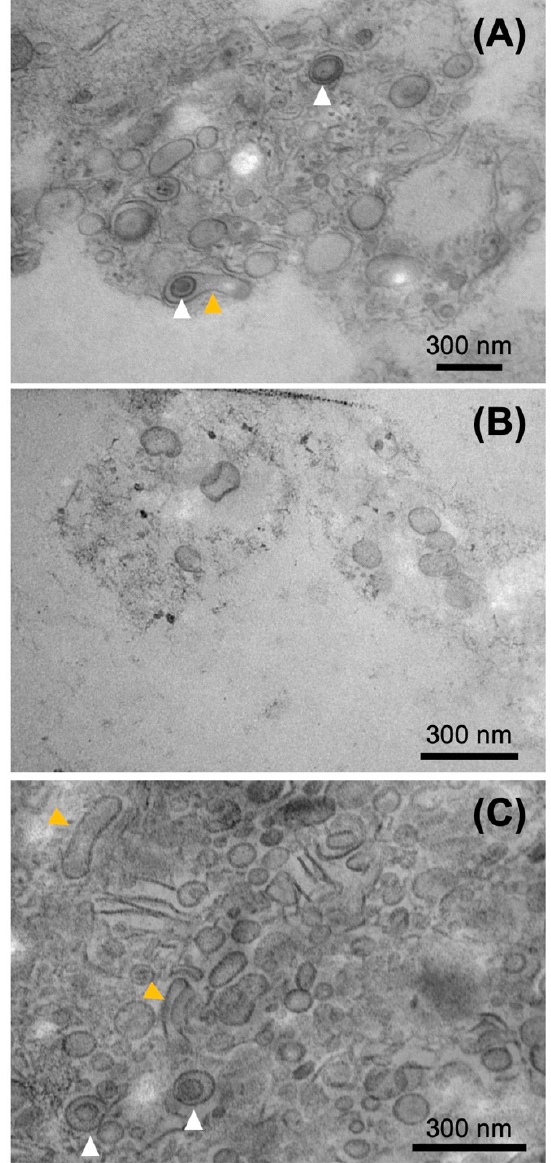
Figure 8. TEM observation of Fractions 0 ( A ), 1 ( B ), and 2 ( C ). Multi-lamellar and pear-shaped EVs are shown by white and orange arrowheads, respectively.